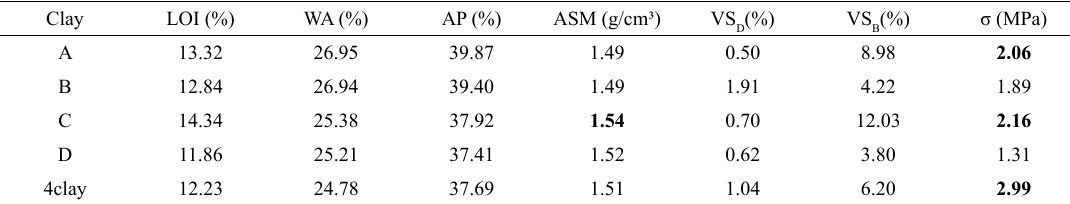
Table 5. Average values of the ceramic properties on the spheres